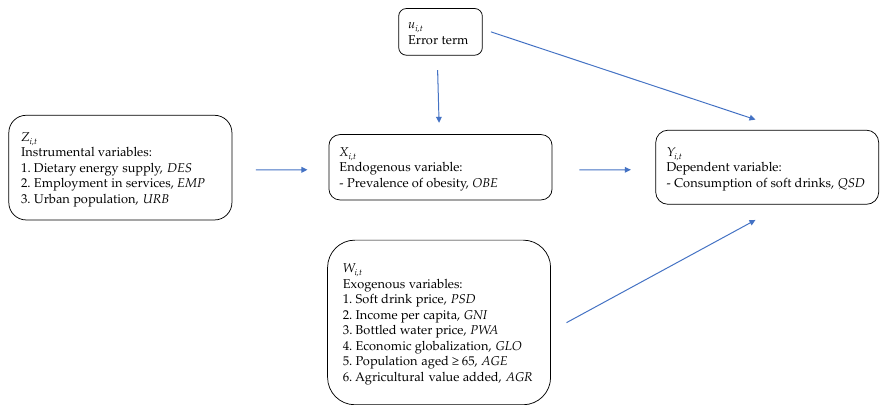
Figure A1. Overview of the regression model. To assess the impact of obesity on the consumption of soft drinks, in the first stage, we regressed the prevalence of obesity ( OBE ) on the instrumental variables Z and the set of exogenous variables W . The predicted value of OBE (denoted 𝑂𝐵𝐸(cid:3555) ) re- sulting from the first stage was thus used in the second stage to estimate the demand for soft drinks.